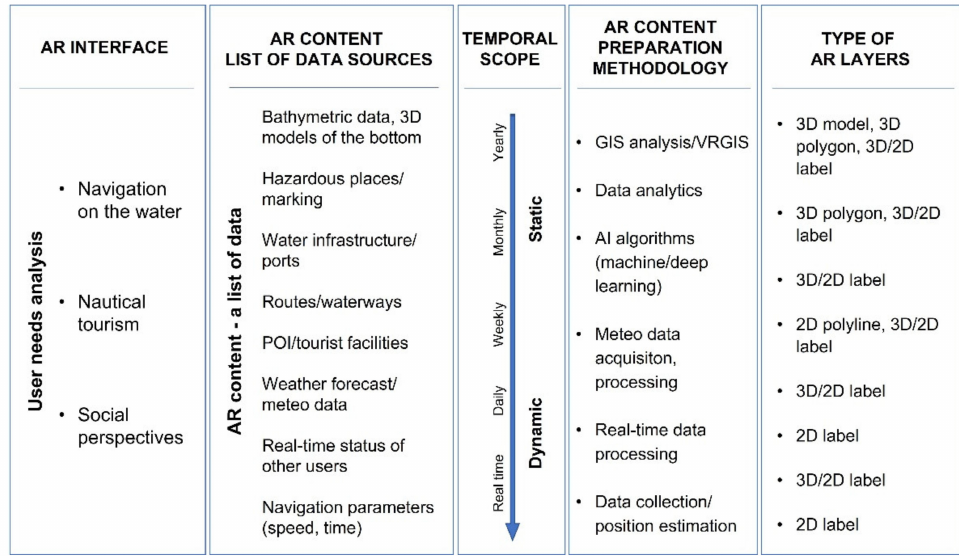
Figure 3. User needs analysis for visual AR interface.